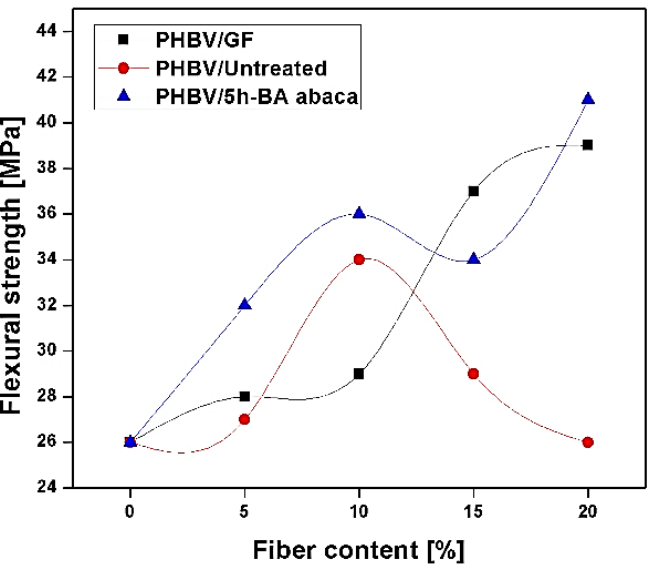
Figure 12. Flexural strength of biodegradable polyester composite-reinforced with glass fiber (PHBV/GF) composite, PHBV/untreated abaca composite, and PHBV/5h-BA abaca composite at different fiber loading (5–20 wt. %). Adapted with permission from Reference [84]. Copyright 2002, with permission from John Wiley and Sons.